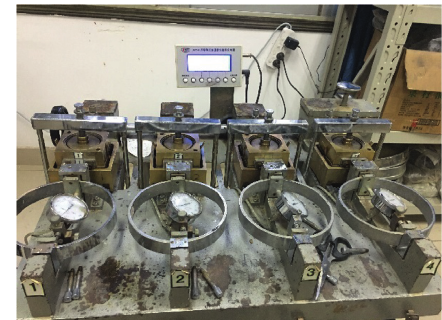
Figure 3: Direct shear test.